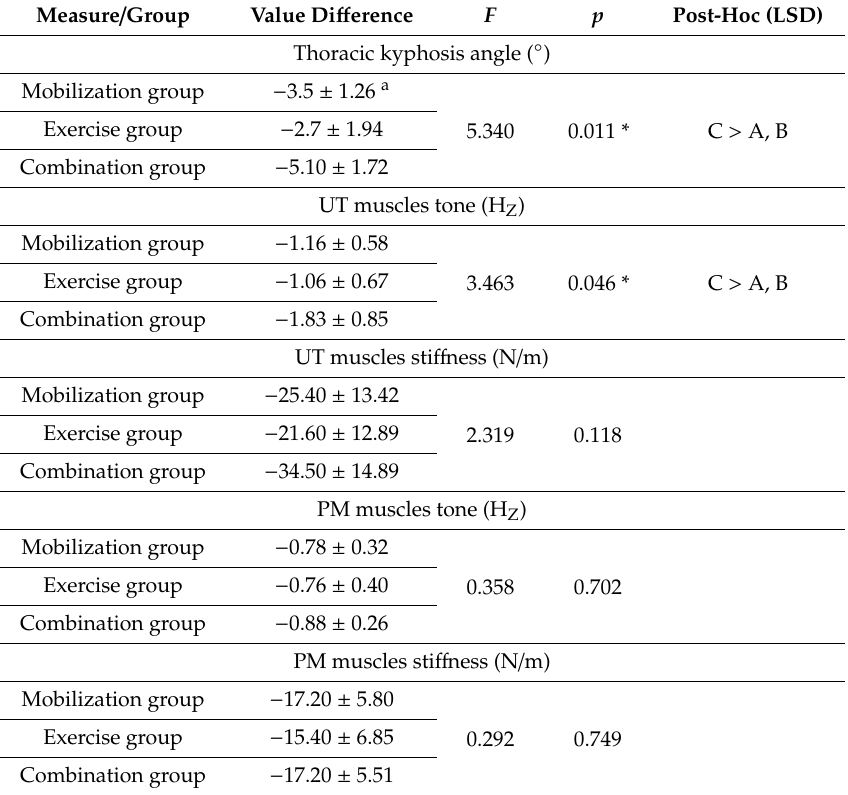
Table 4. Comparison of the thoracic kyphosis angle, UT and PM muscles tone, and sti ff ness in three intervention